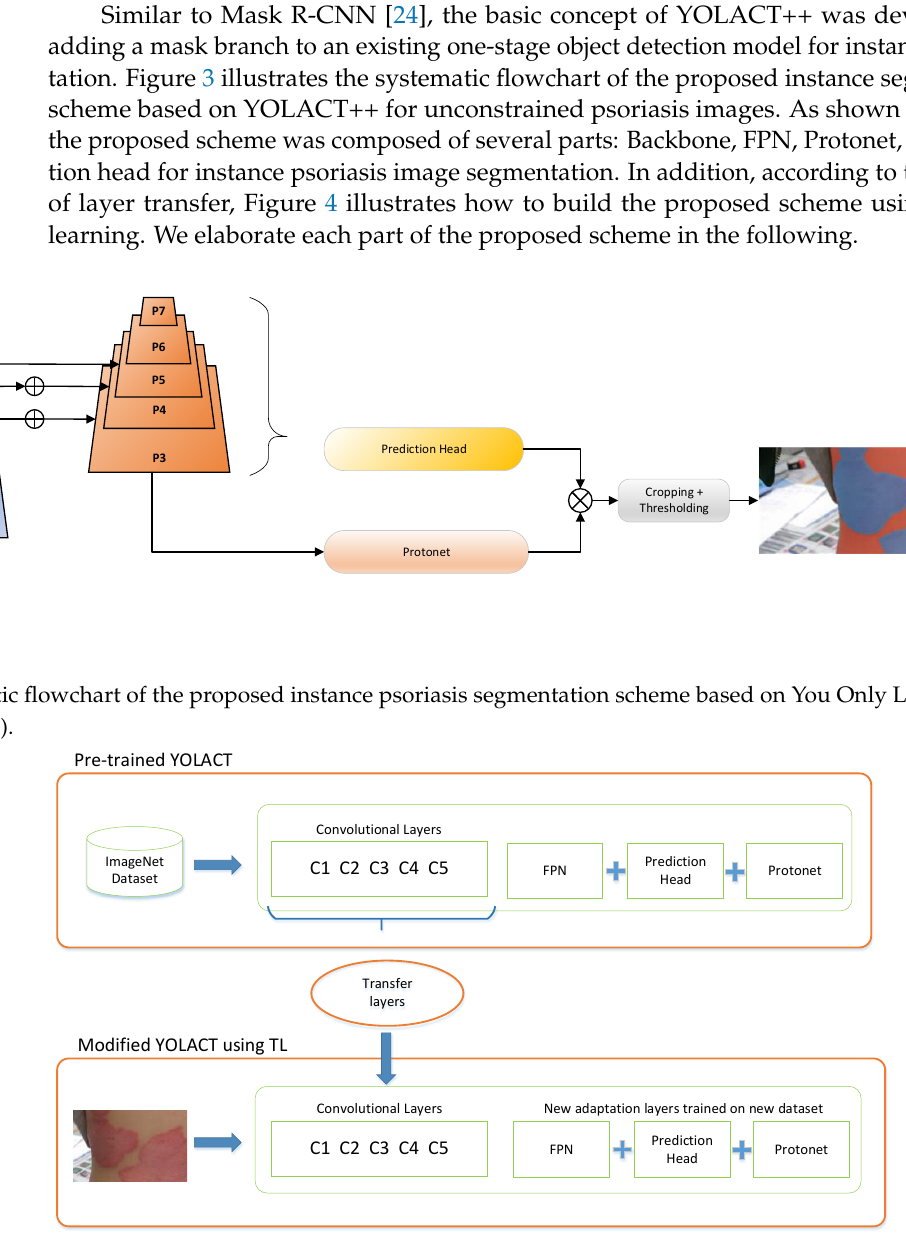
Figure 4. Illustration of building the proposed scheme using transfer learning.